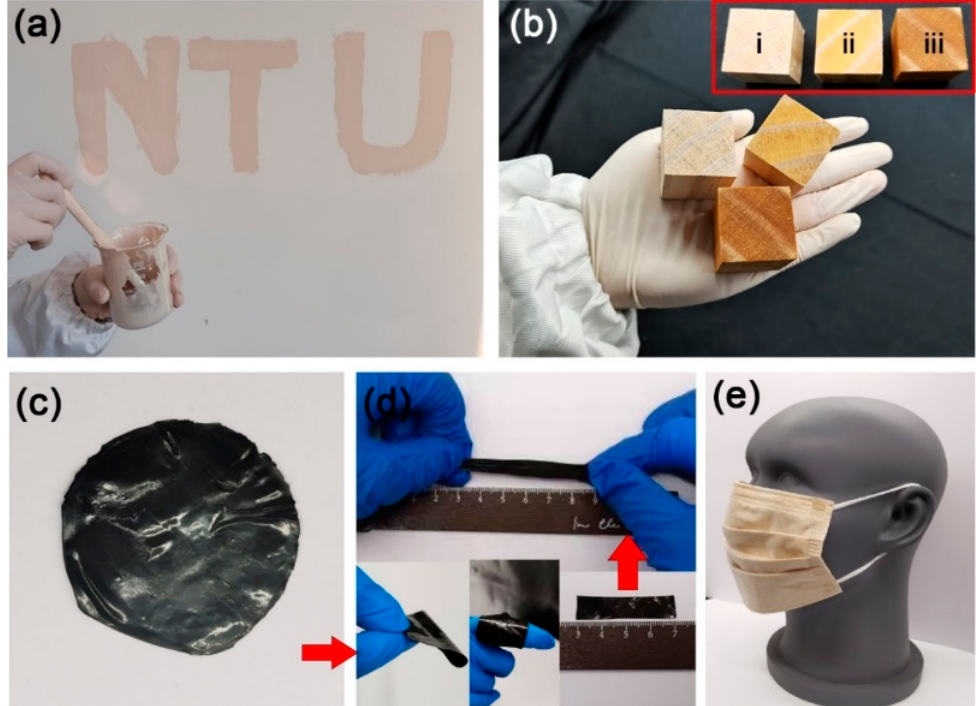
Figure 2. Nanosilver glue is compatible with commercial materials ( a ) latex paint and ( b ) varnish, which can be painted on the wall and wood: inset in b shows the photos of (i) untreated, (ii) varnish- coated, and (iii) varnish/nanosilver-glue-coated wood. Nanosilver glue can be dried to form a ( c ) flexible film and tailored to ( d ) desired shape. ( e ) shows a nanosilver-glue-treated surgical mask, which consists of three layers, and nanosilver-glue-coated viscose nonwoven fabric is located in the interlayer.